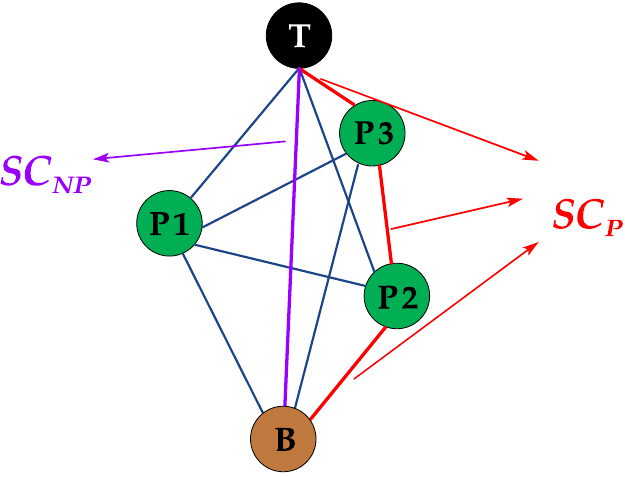
the absence of PRDs, which is SC NP . The final FSRA is obtained according to Equation (10).